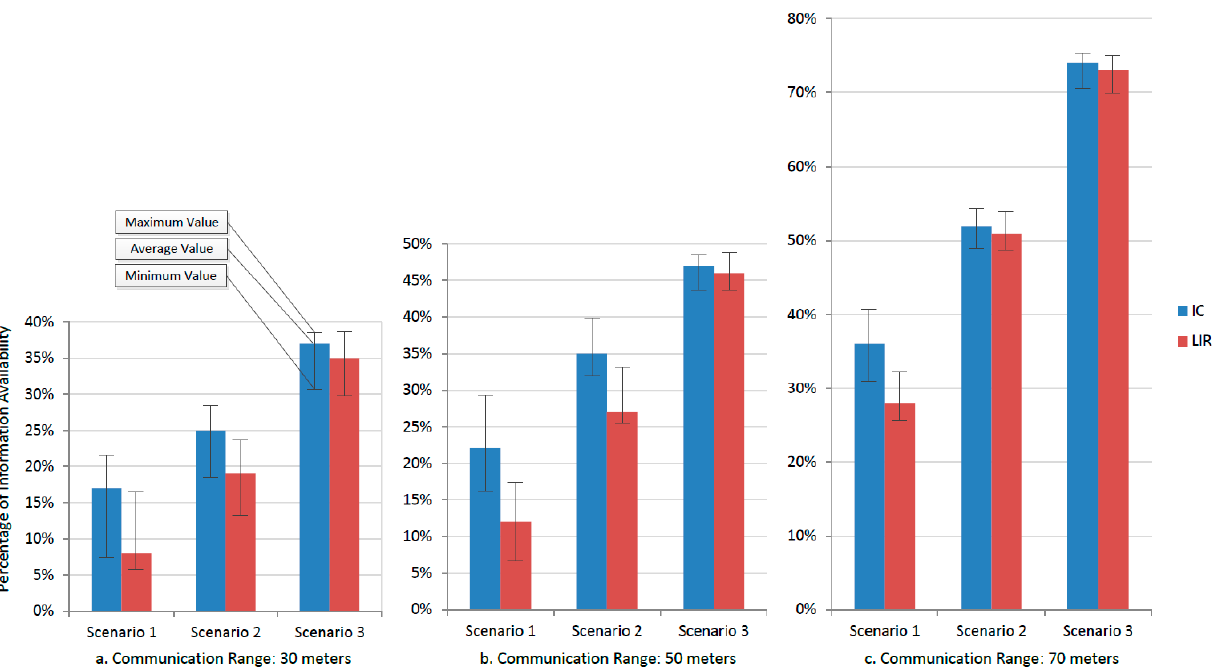
Figure 11. Information availability to the IC and